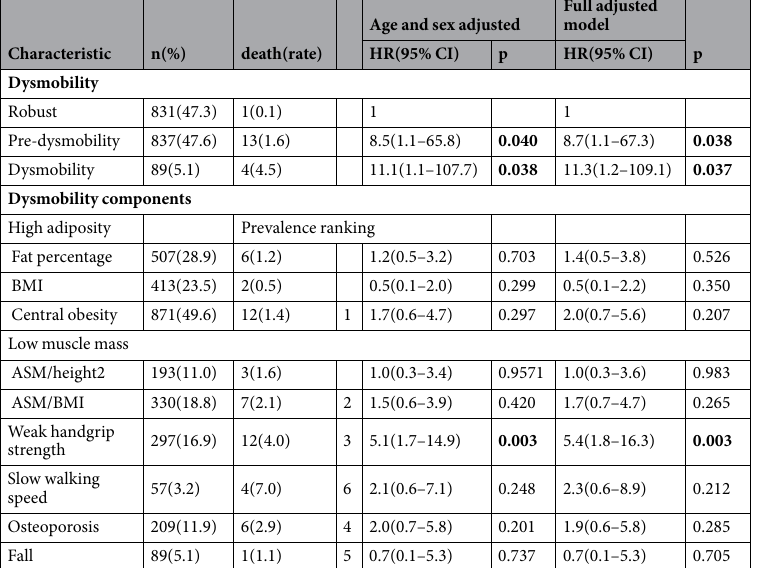
Table 3 showed the effectiveness of mortality prediction of dysmobility syndrome by different definitions. In this study, we compared skeletal muscle index defined by different operational criteria. Both original dysmobility syndrome defined by Binkley, et al . and dysmobility syn- drome using BMI-adjusted muscle index were associated with mortality. However, using the definition of dysmo- bility syndrome modified by BMI-adjusted muscle index eventually identified a higher prevalence of dysmobility syndrome. Major contributive components change and distribution of 6 components by different definitions were presented in Fig. 3.